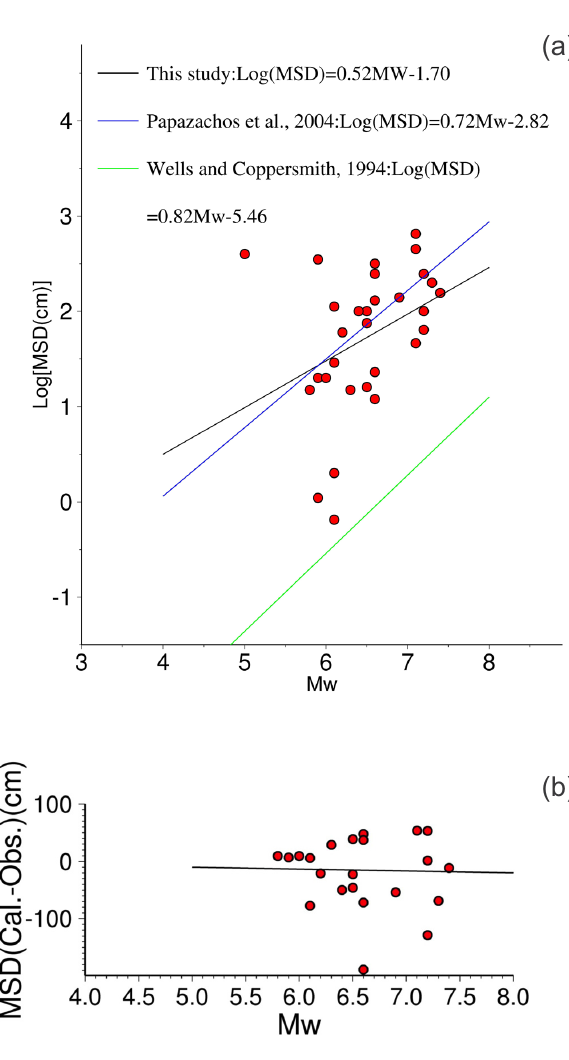
Figure 7. (a) Relation between coseismic fault displacement and M for 30 mid-plate earthquakes in Iran; (b) reliability test for this W diagram using 22